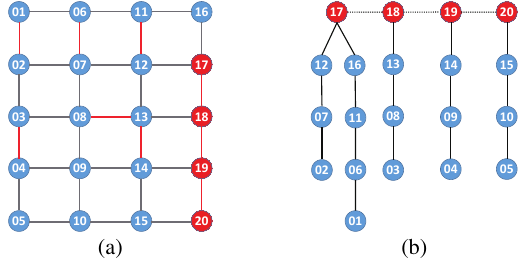
Figure 5. An illustration of finding the optimal correction order: (a) the graph of 20 images in 4 strips with 5 images each, whose arcs are labeled in red (consistent arcs) or in blue (inconsistent arcs). The nodes of the reference subset are labeled in red as the root ones. (b) the spanning tree generated by the shortest path algorithm, which is applied with the costs between reference images set as 0. The optimal correction order is the result of the breadth-first search from root